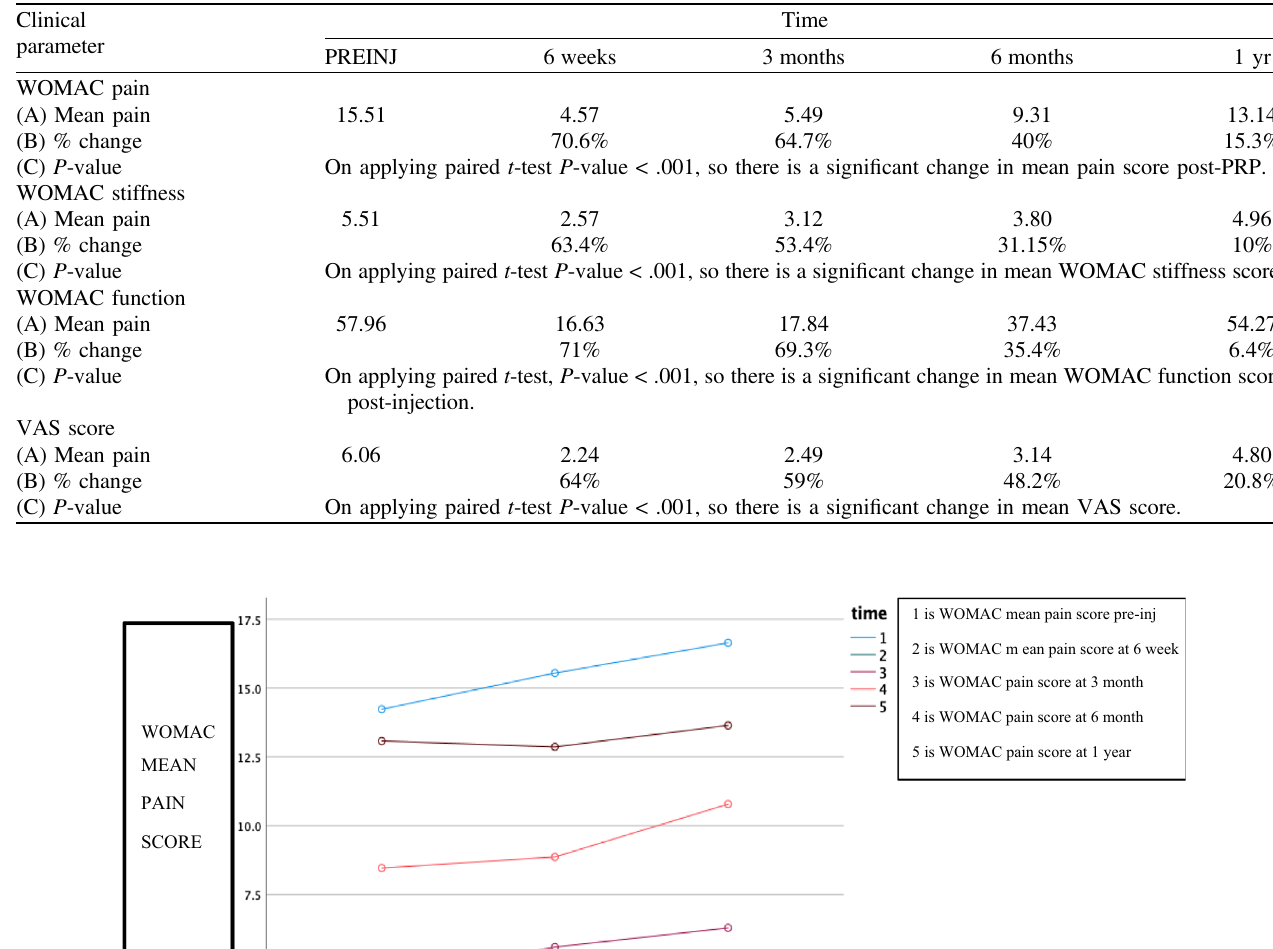
Table 1. Percentage change in WOMAC and VAS scores at 6 weeks, 3 months, 6 months, and at one year after PRP injection compared to pre-injection levels. On applying paired t -test, P -value <.001, so there is a signi fi cant change in mean VAS and WOMAC function score post- injection.